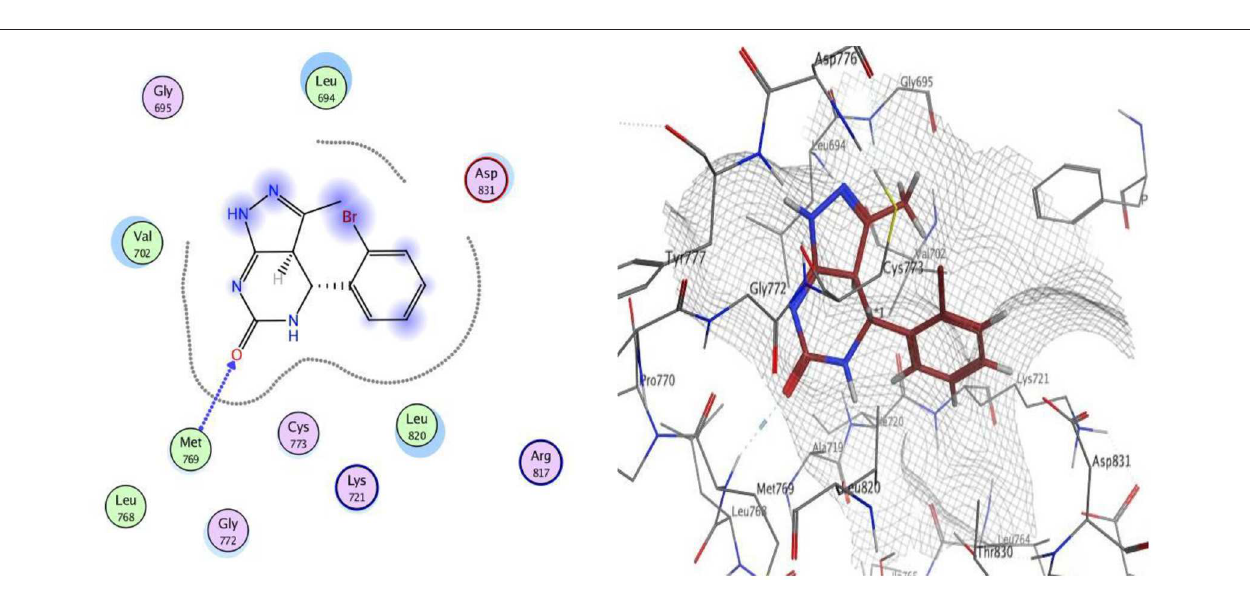
FIGURE 3 | 2D and 3D interaction map of compound 12 within the active site of EGFR